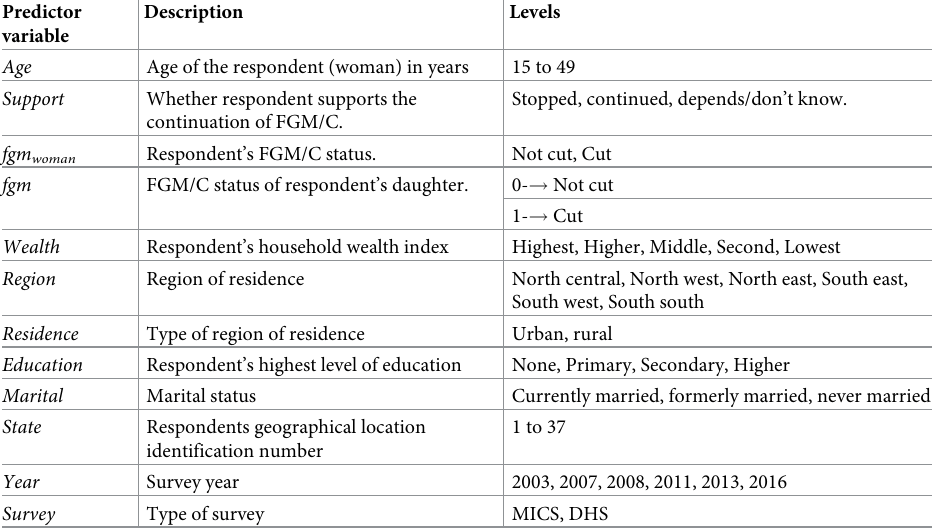
Table 1. Variable names, levels and